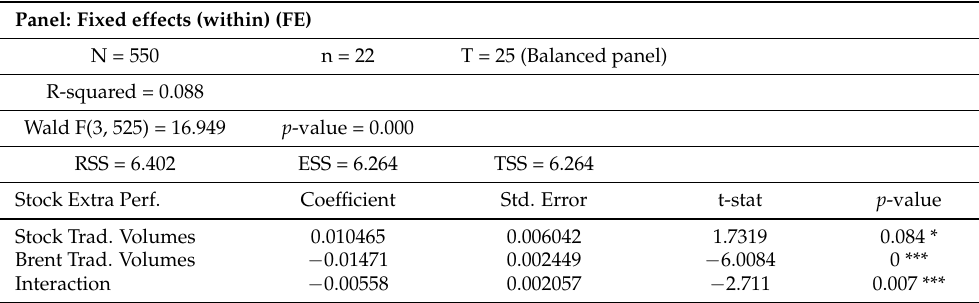
Table 5. Relationship between extra return, oil and trading volumes before the COVID-19 pandemic. Panel: Fixed Effects (within) (FE) N = 1078 n = 22 T = 49 (Balanced panel) R-squared = 0.095 Wald F(3, 1053) = 36.755 p -value < 0.001 RSS = 34.686 ESS = 12.274 TSS = 12.274 Stock Extra Perf. Coefficient Std. Error t-stat p -value Stock Trad. Volumes 0.066 0.008 7.952 0.000 *** Brent Trad. Volumes − 0.021 0.003 − 6.699 0.000 *** Interaction − 0.013 0.006 − 2.345 0.019 **